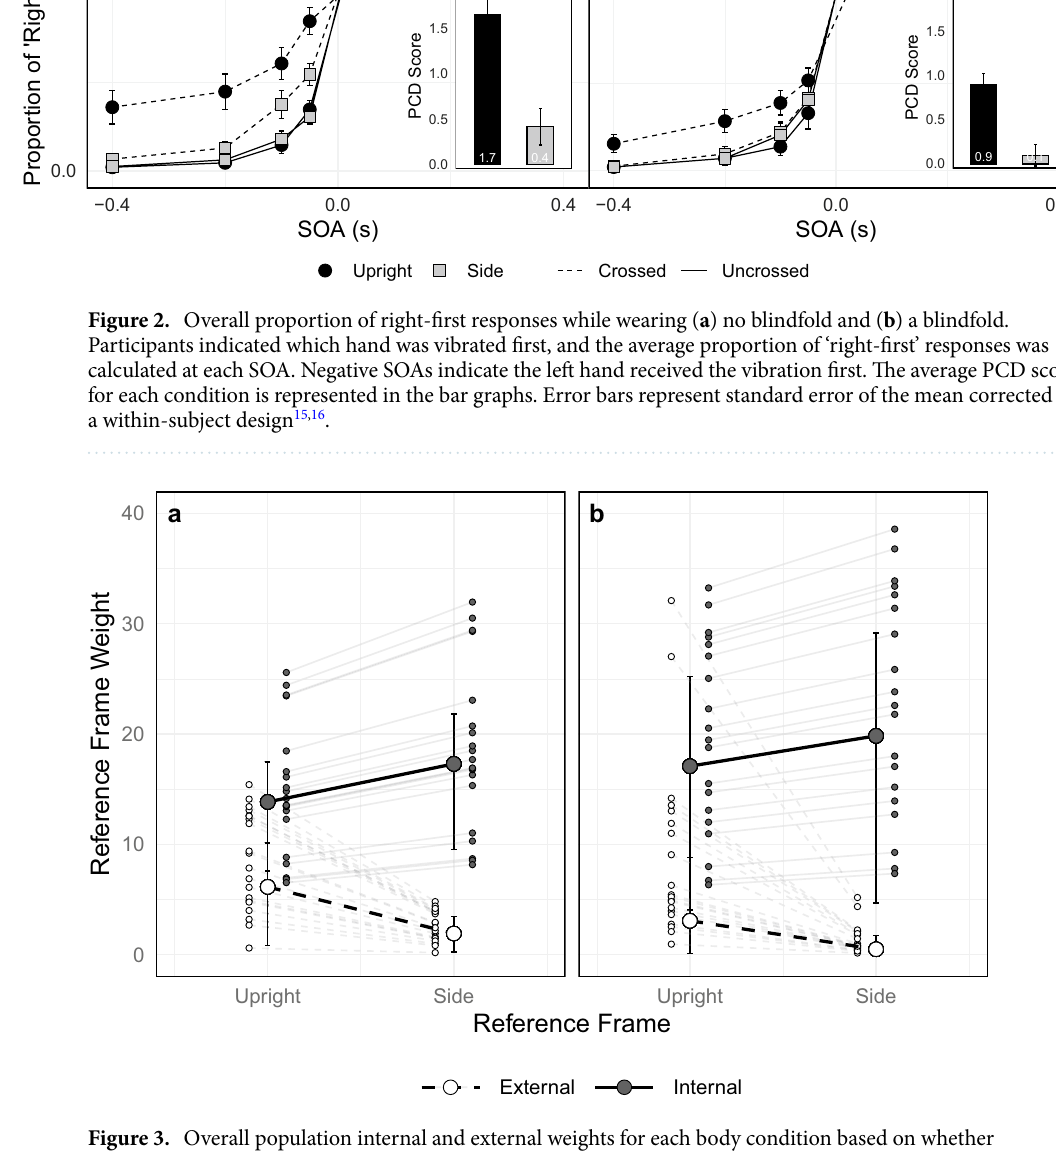
Figure 3. Overall population internal and external weights for each body condition based on whether participants were wearing ( a ) no blindfold or ( b ) a blindfold. Error bars represent 95% credible intervals calculated directly from the MCMC posterior distributions. The small circles represent individual participant